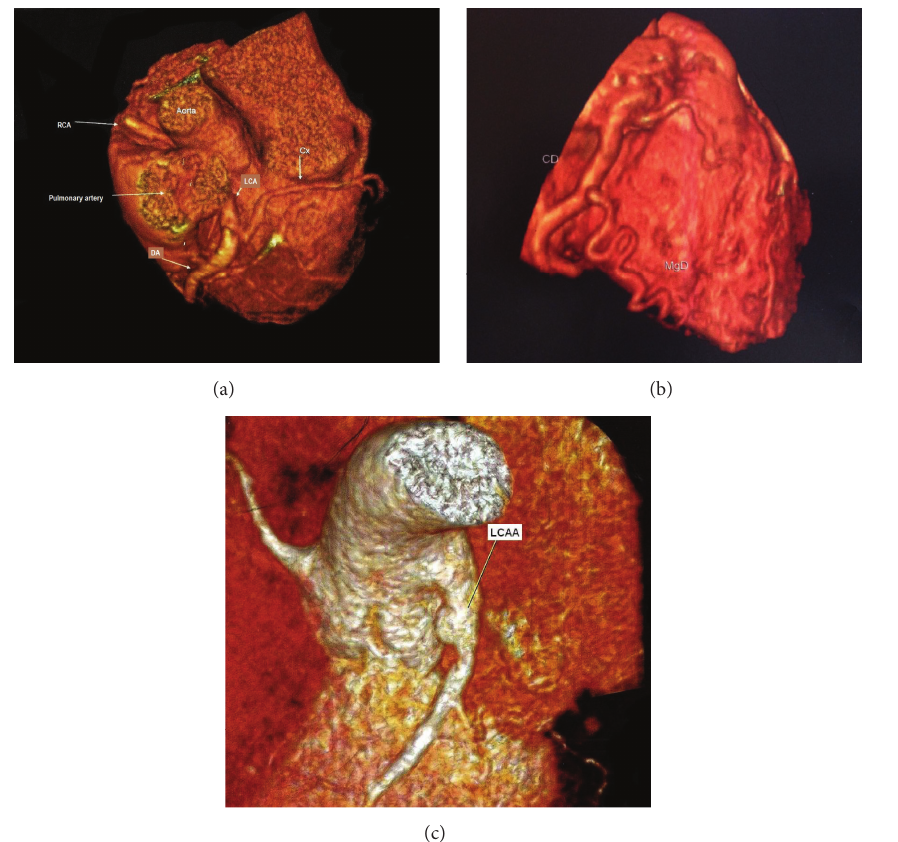
Figure1:(a)Computedtomography(CT)angiographyshowingtheleftcoronaryartery(LC)fromthepulmonarytrunk(RCA:rightcoronary artery; AD: anterior descending artery; and Cx: circumflex artery). (b) CT angiotomography showing the coronary collateral network. (c) CT angiotomography showing the left coronary artery